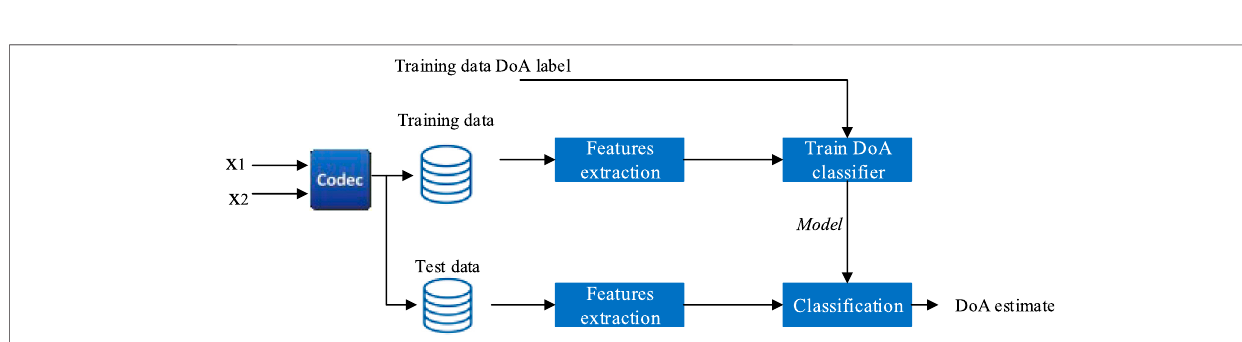
FIGURE 2 | System diagram of the proposed learning-based approach for DoA estimation.